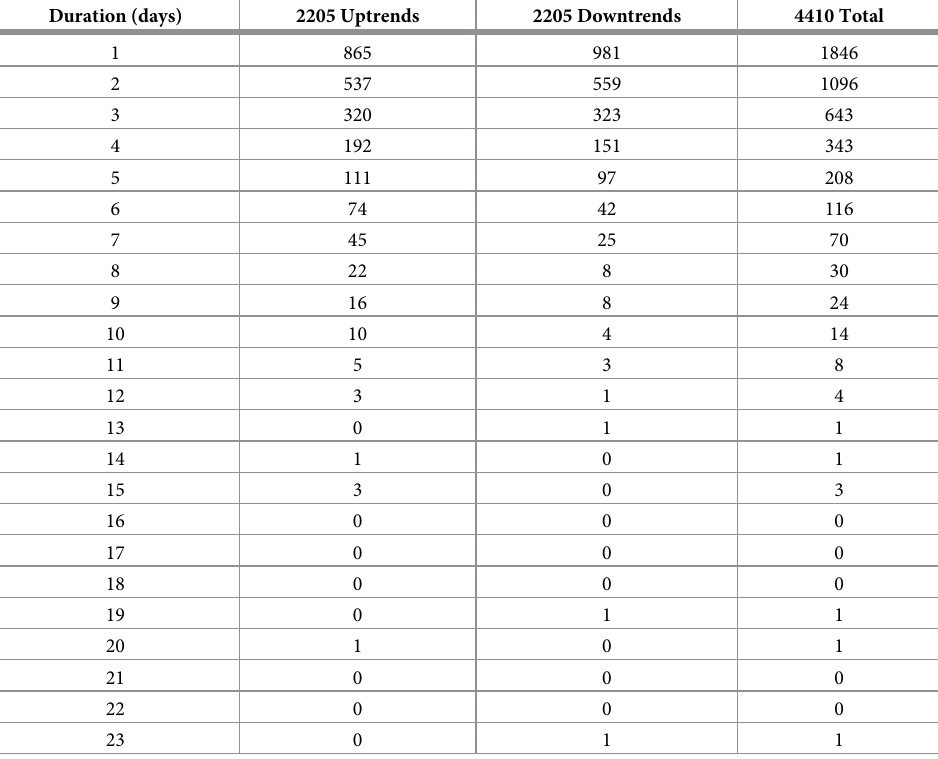
Table 4. Composition of uninterrupted trends found in the IPC data